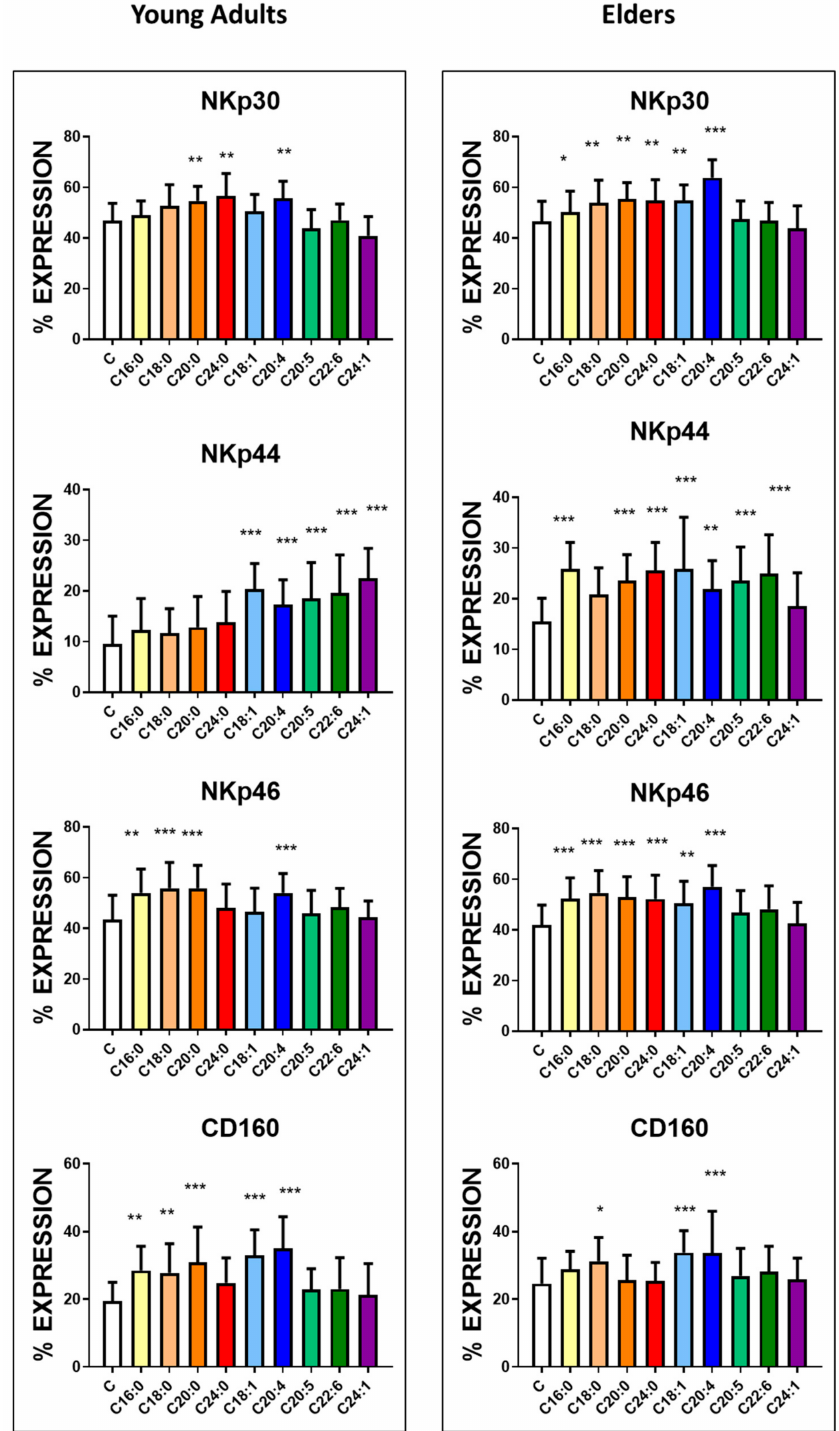
Figure 3. Expression of NKp30, 44 and 46 and CD160 upon treatment with fatty acids and assessed by flow cytometry. NK cells purified from the blood of the healthy young adults (23 ± 4 years old) and healthy elder (63 ± 5 years old) volunteers were treated with 10 µ g / mL concentration of the following fatty acids for 24 h. The expression of the receptors was assessed by flow cytometry. The results represent the percentage mean and SD for each group ( n = 30). The treatments were compared by one way ANOVA. Bonferroni significance post-test are represented. * p < 0.01, ** p < 0.001 and *** p < 0.0001. The mean channel fluorescent intensity (MFI) is represented in Supplementary Figure